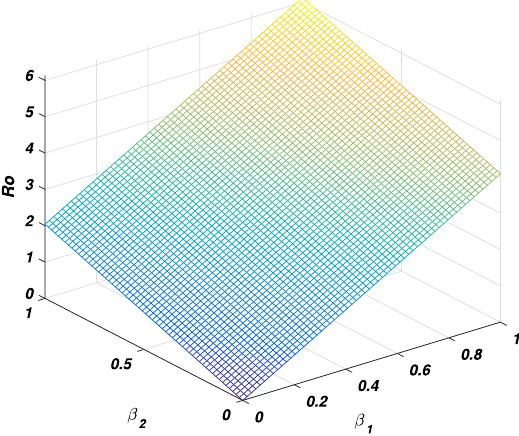
Figure 2. The picture visualizes the variation of the reproductive number against β 1 and β 2